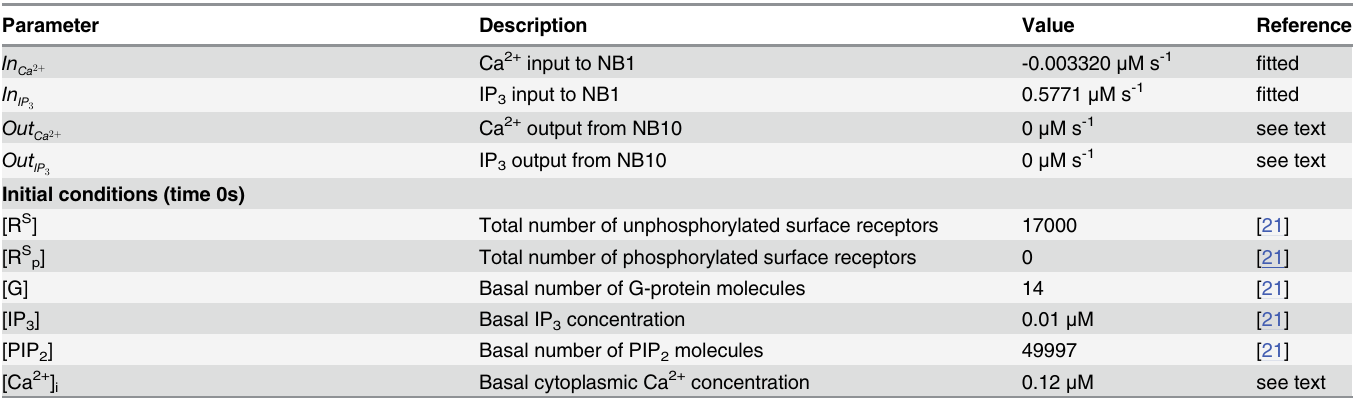
Ligand diffusion in the extracellular space is modelled according to thin film solution to Fick ’ s diffusion law [32] as follows describing the ligand concentration (L) as a function of